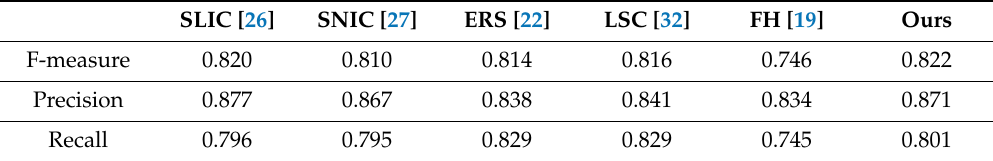
Table 3. Performance metrics of the framework on